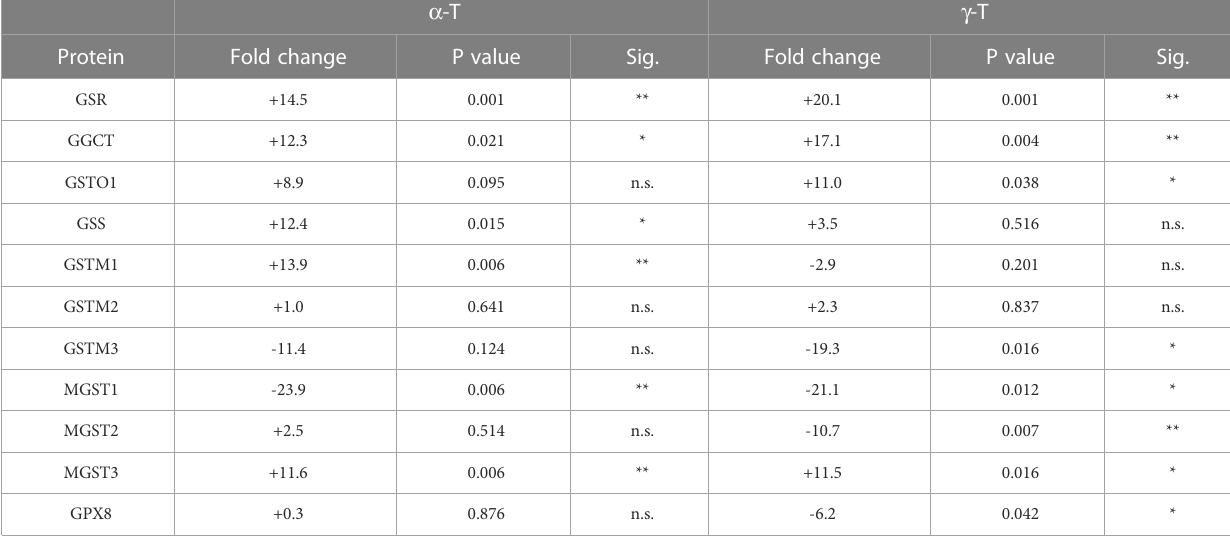
TABLE 4 The effect of a T and g T on the expression of proteins involved in glutathione metabolism and transfer. a -T g -T Protein Fold change P value Sig. Fold change P value